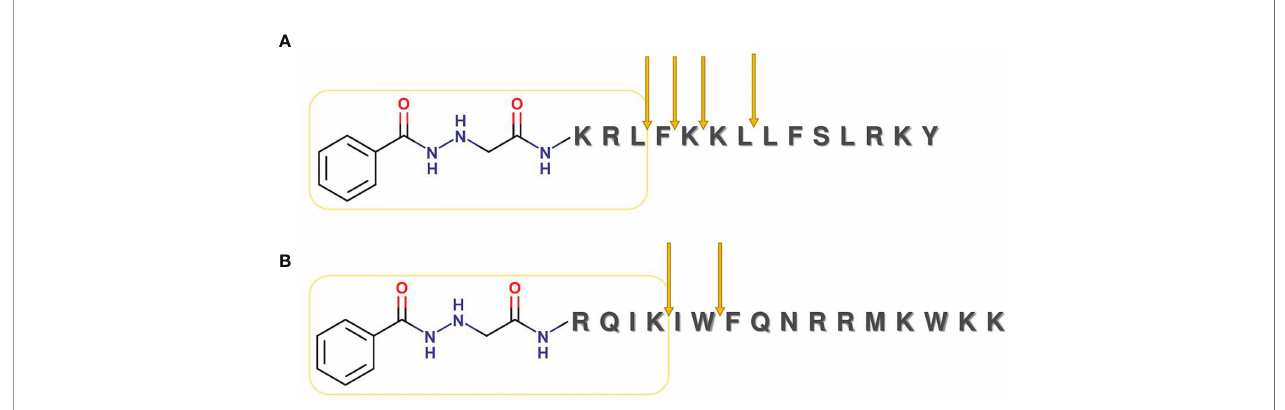
FIGURE 4 | Lysosomal degradation of INH-Dhvar4 (A) and INH-penetratin (B) conjugate. Conjugates were incubated with rat liver homogenate, and samples from different time points were analyzed by LC-MS. For the detailed analysis (chromatograms and mass spectra), see Supplementary Figure